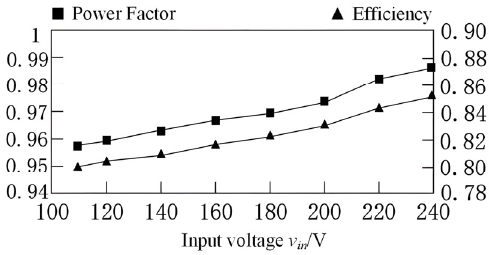
Figure 13. PF and efficiency of the proposed LED driver.